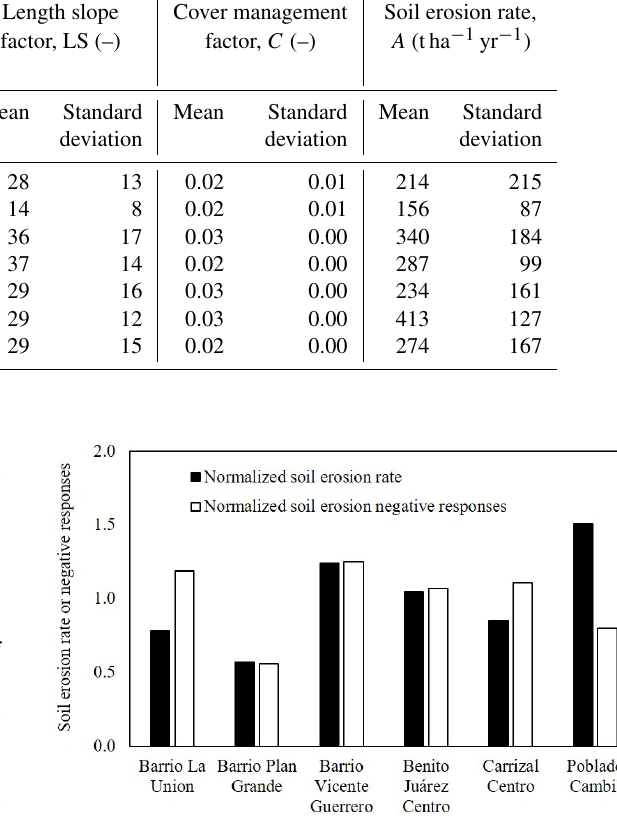
Figure 2. Combined results from Tables 2 and 3: normalized soil erosion rates and negative responses from the six study communi- ties. Normalized soil erosion rates are calculated as the ratio of the average erosion rate for each community to the overall averages (see Table